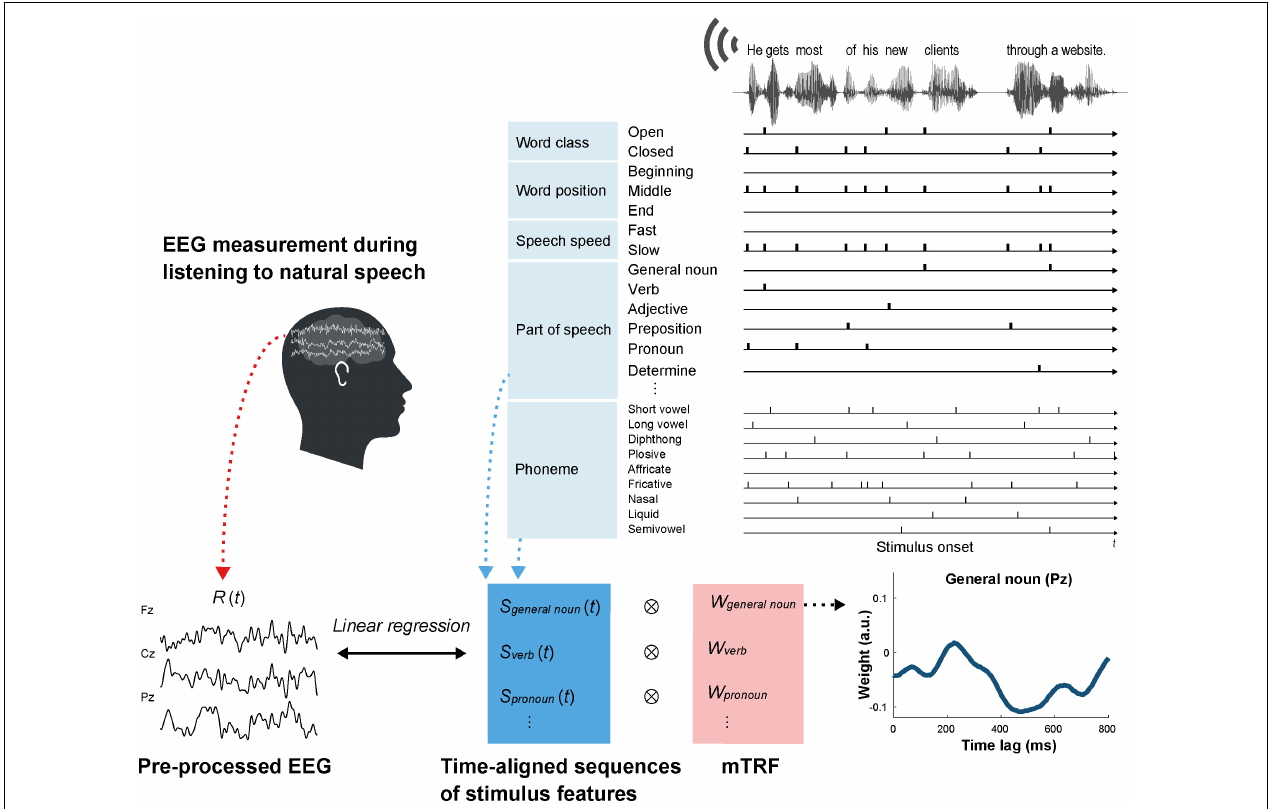
FIGURE 1 | Outline of mTRF estimation for the word features in English